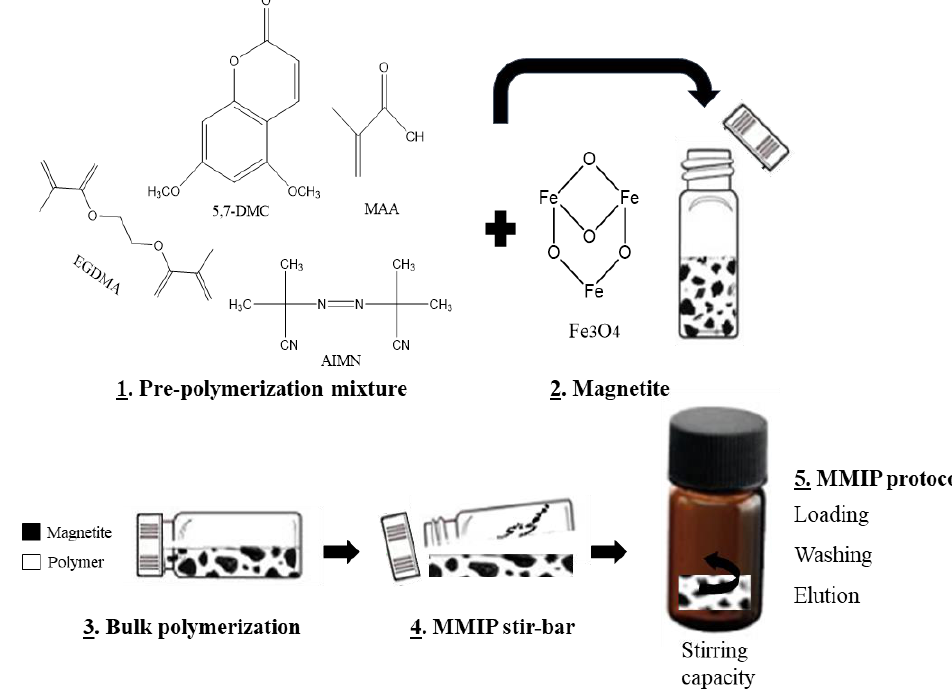
Figure 9. Steps of fabrication and application of the magnetic molecularly imprinted stir-bars (reprinted with permission from reference [81]).